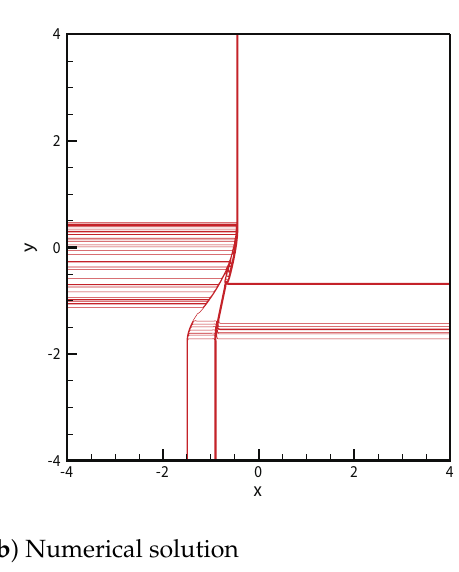
Figure 12. Case 12. S δ + R + SJ + RJ